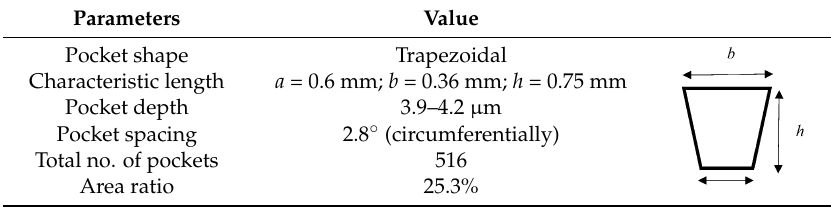
Table 2. Sample’s specifications.